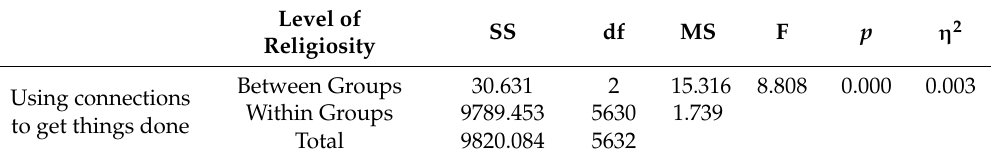
Table A10. Using connections to get things done among different levels of religiosity.